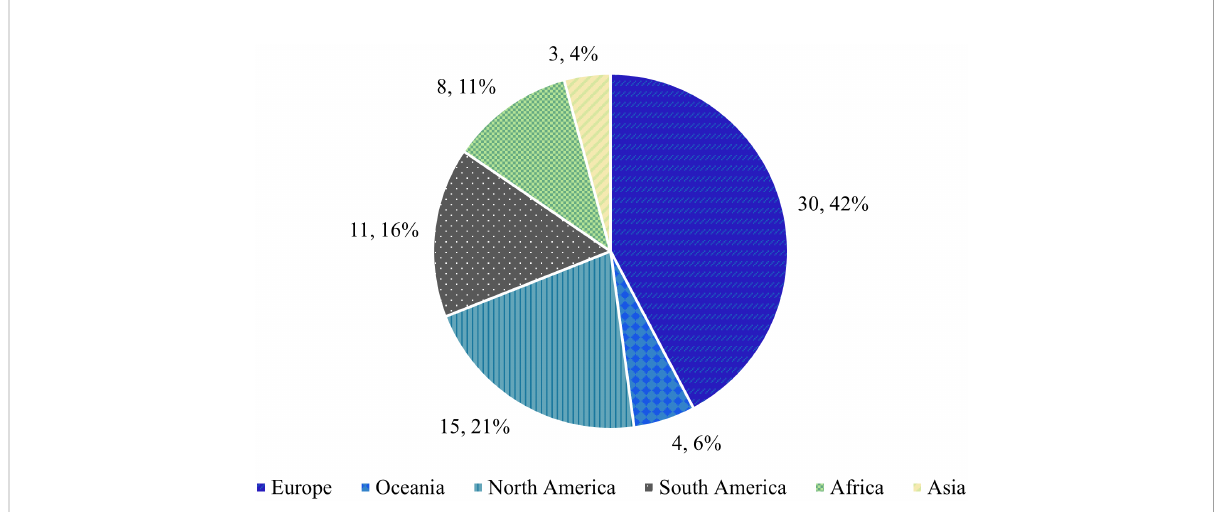
FIGURE 2 Number and percentage of studies included in the fi nal scoping review analysis reported by demographic region 1 ( n = 69 2 ). Results are reported as ( n , %). 1 Study locations were categorized into geographic regions as de fi ned by the United States Department of Homeland Security ’ s Of fi ce of Immigration Statistics (DHS, 2022). 2 Two studies took place in more than one